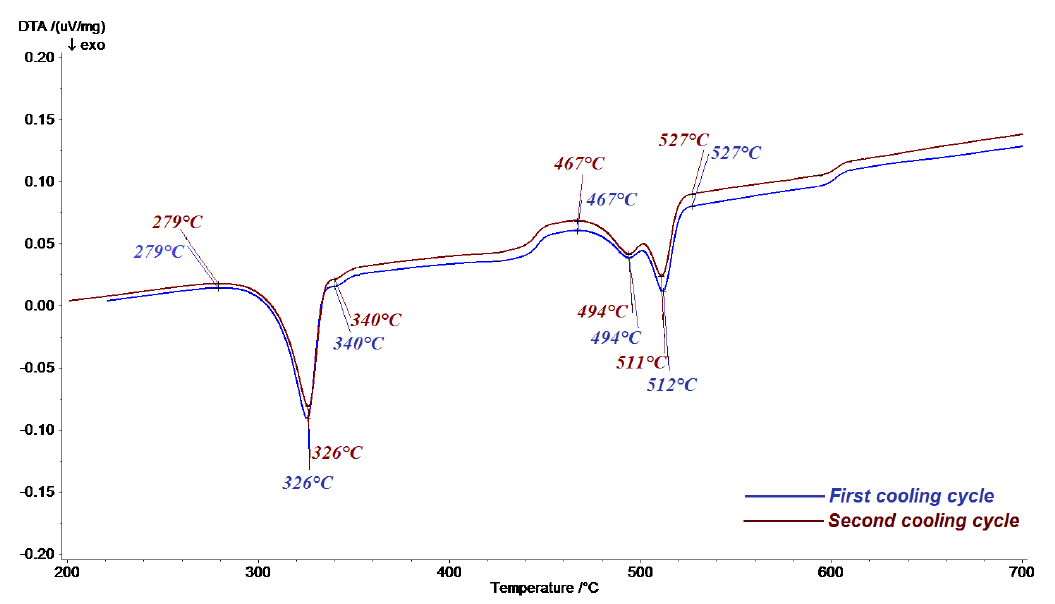
Figure 2. Thermograms of the first (blue) and second (brown) cooling cycle of the sample Mg–Zn–KCl–NaCl–CaCl 2 –NdF 3 up to 200 °C.